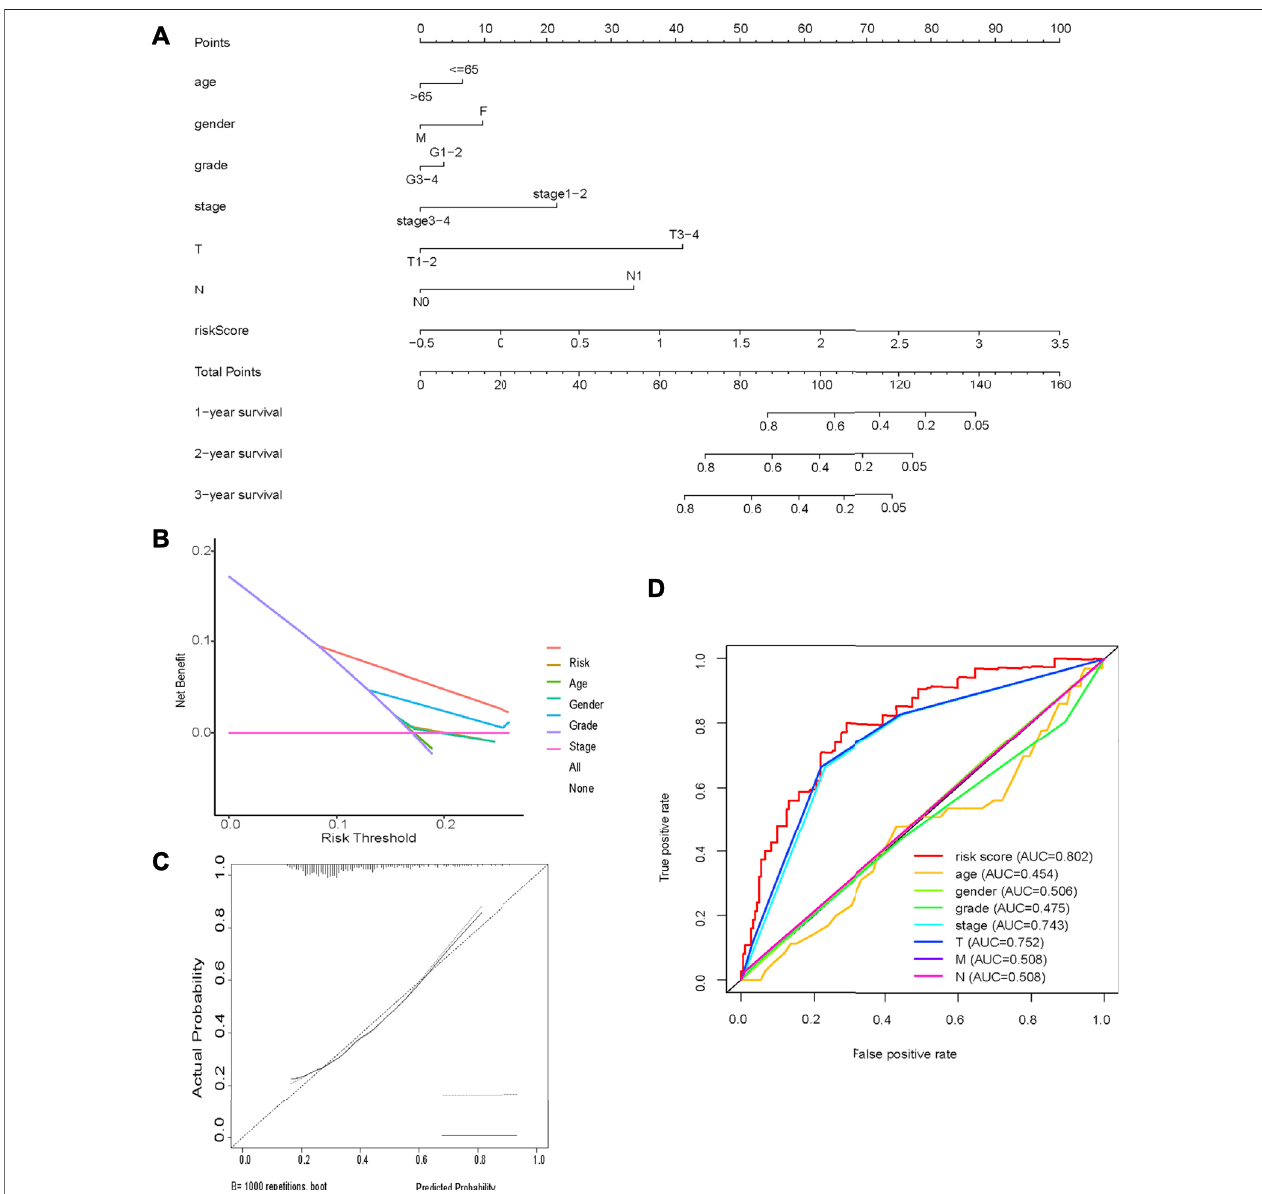
FIGURE8| Nomogram (A) Nomogramincorporatingprognosticfactors (B) Decisioncurveanalysis; (C) Calibrationcurvesshowedgoodconsistencybetweenthe nomogram prediction and the actual observation; (D) Time-dependent ROC curve analysis.